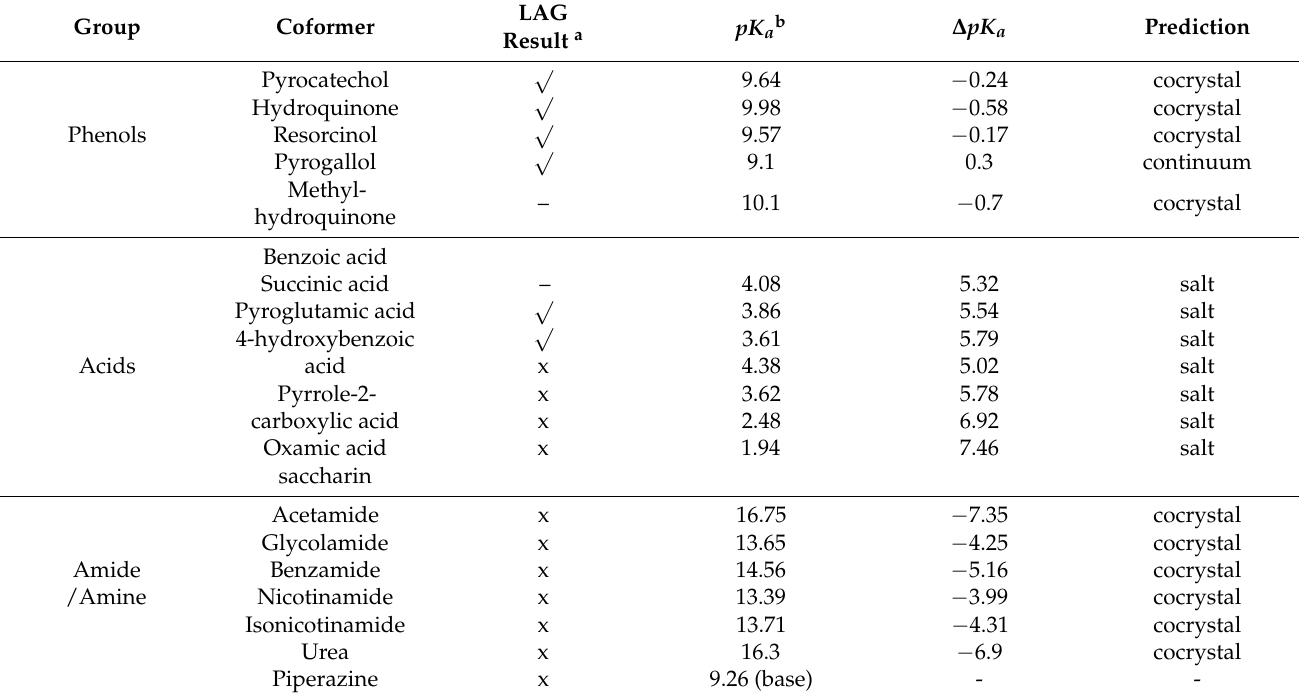
Table 1. Summary of the coformers used for the formation of cocrystals with VPZ ( pK a =